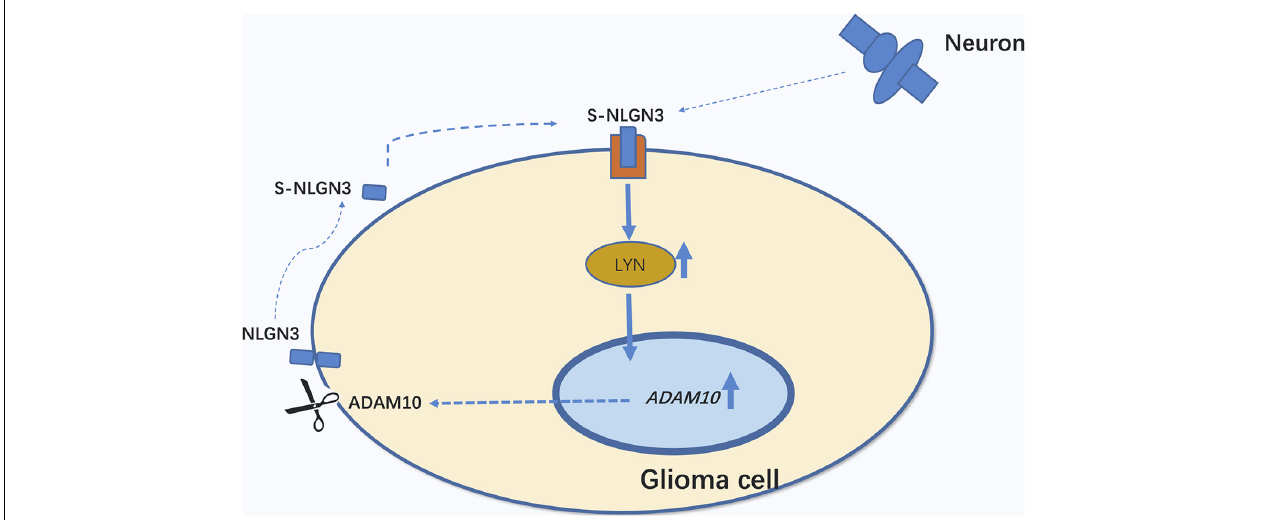
FIGURE 6 | Schematic illustration of the positive feedback circle, s-NLGN3/LYN/ADAM10. Secreted NLGN3 derived from neurons and glioma cells activates LYN and then up-regulates ADAM10 expression, which can cleave NLGN3 to promote its